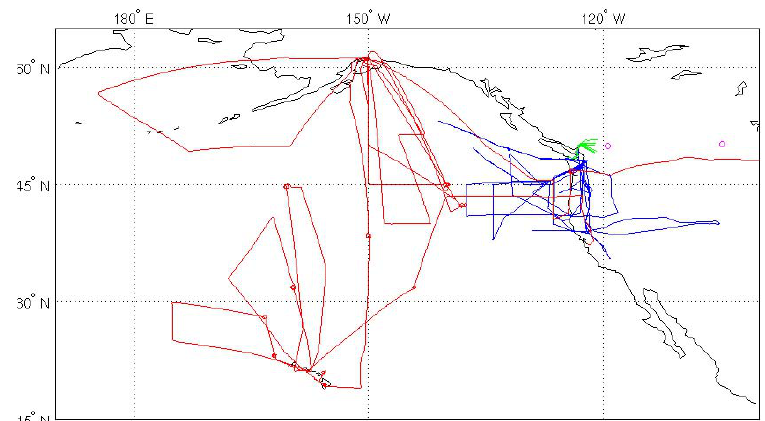
Fig. 1. Flight tracks for the NASA DC-8 (red), NCAR C-130 (blue), and Canadian Cessna (green) aircraft platforms during INTEX-B between April 17 and May 17, 2006. Also plotted are the IONS ozonesonde sites (magenta circles) at Kelowna, BC and Bratt’s Lake,